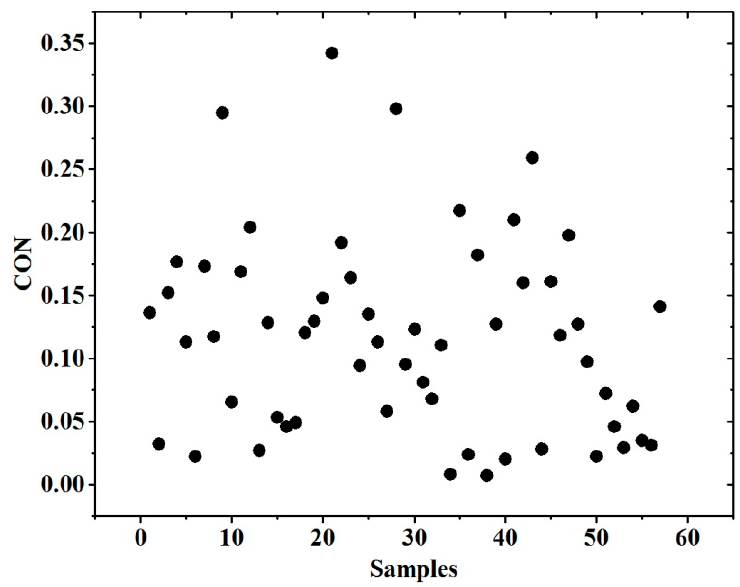
Figure 4. Scatter diagram of contrast (CON) values of the samples.